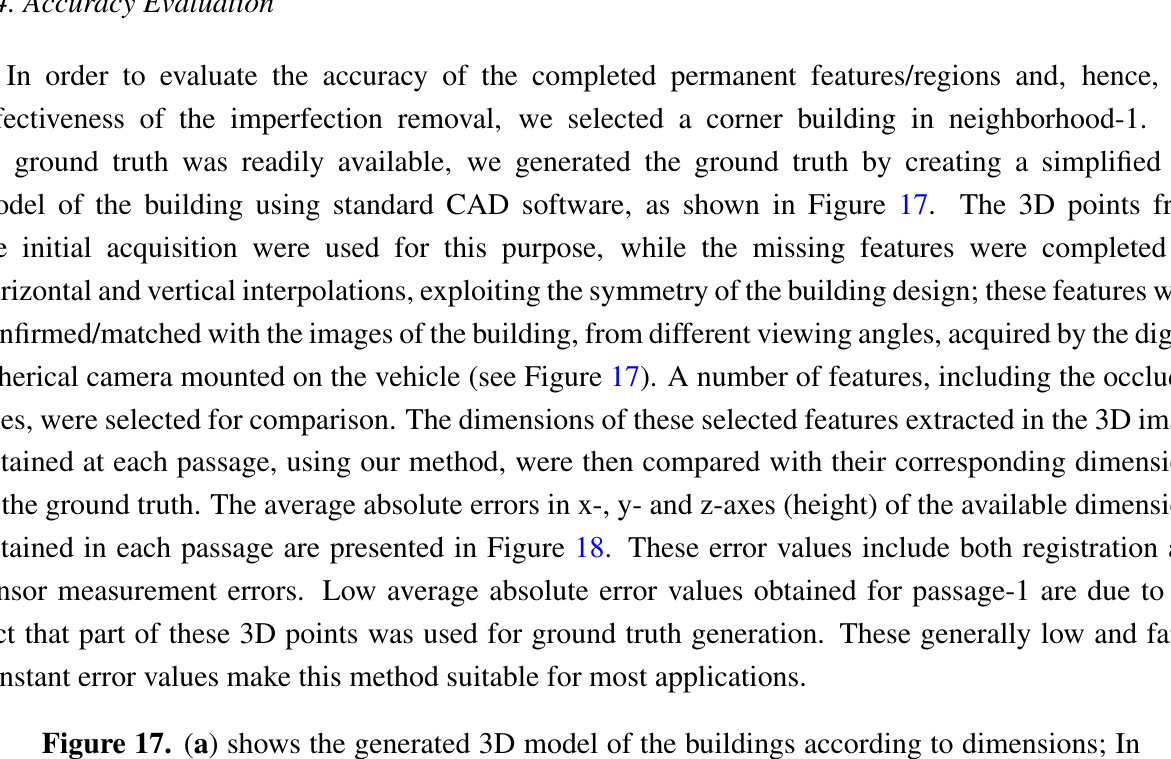
Table 4. Classification results for permanently static objects ( F